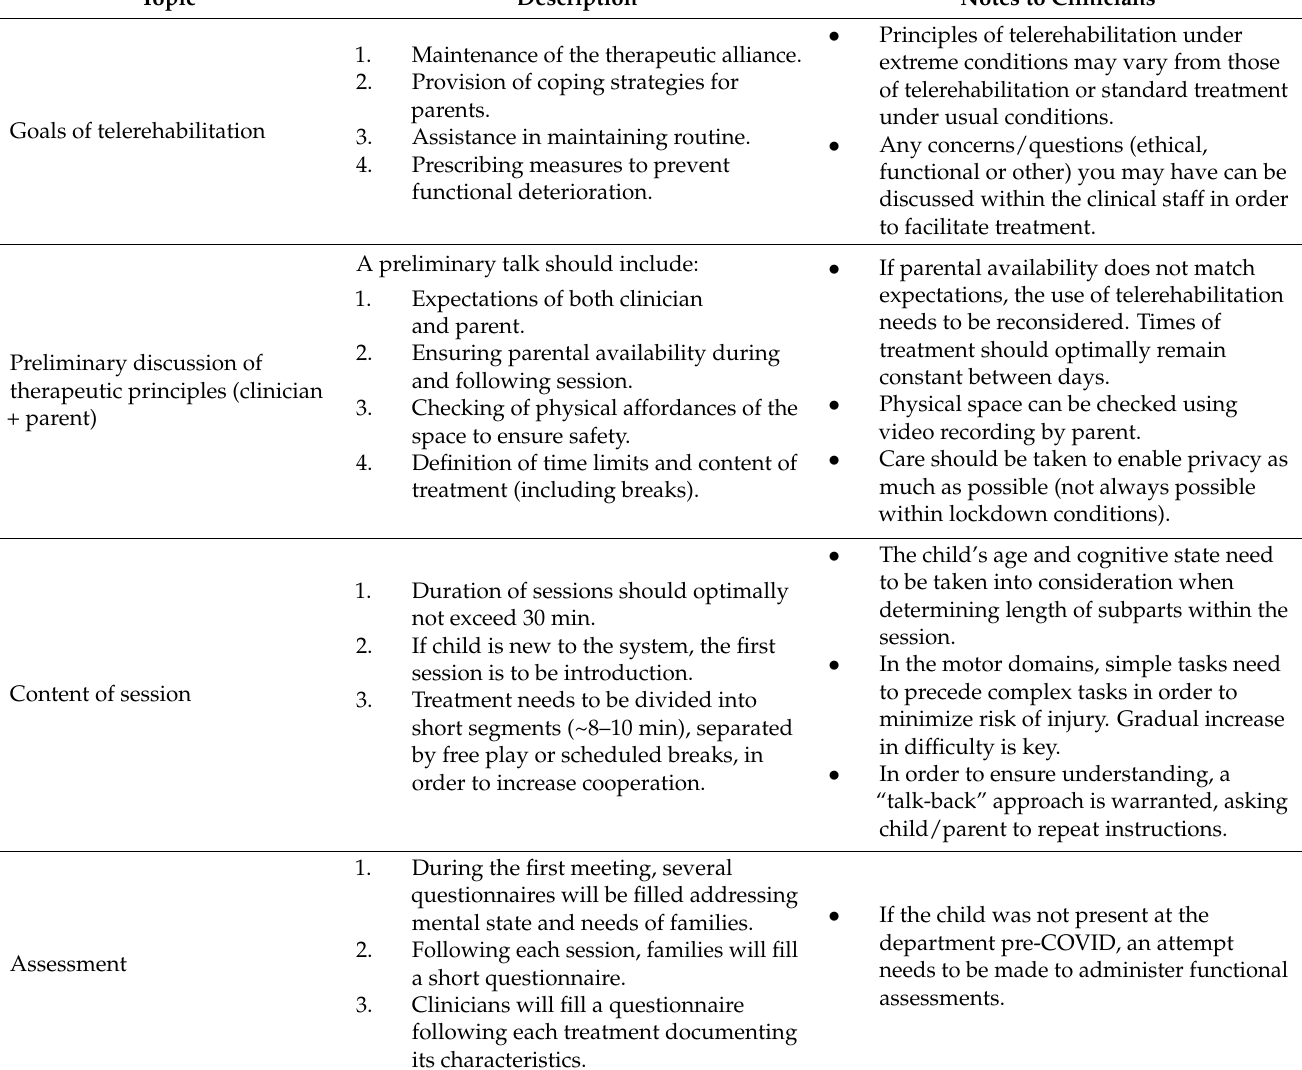
Table 1. Guidelines for pediatric telerehabilitation under COVID-19, administered to clinical staff at the department following the work of the focus